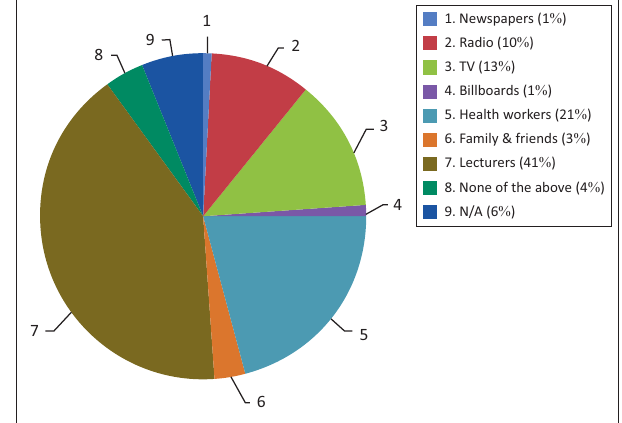
FIGURE 2: Pie chart showing where physiotherapists were first exposed to health